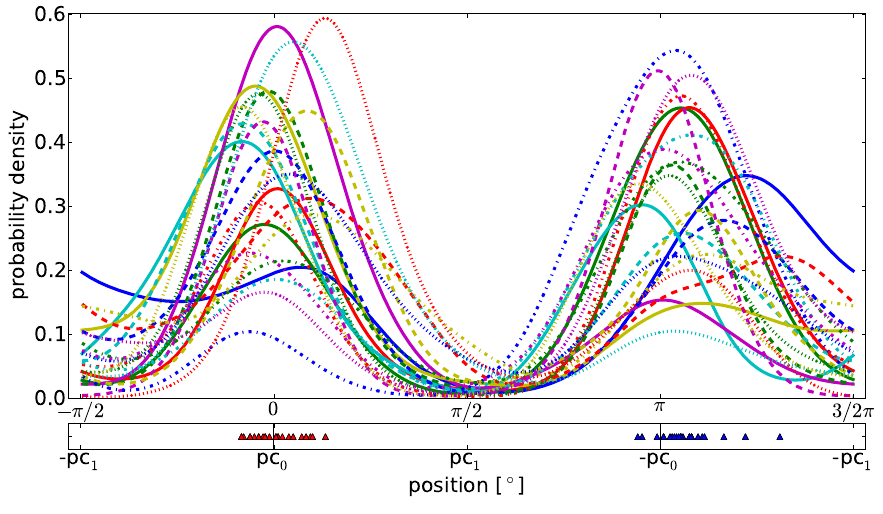
Figure 8 . ( Upper graph ) Gaussian kernel density estimation for binocular microsaccades which fit to our model and ( lower graph ) representation of the most probable shape combination of pc 0 and pc 1 for each individual participant. Each microsaccade coef- ficient pair ( c 0 , c 1 ) is transformed to the one dimensional α ( l ) with l being the index of a microsaccade. The density estimation reveals the dominance of the first principal shape pc 0 (localization around 0 and π ) above pc 1 . The lower graph shows the distribution of the most probable shapes in left and right direction and supports the former statement. This result holds for all participants. The contribution of the second component pc 1 to the microsaccade shape differs between them which we see in the different widths of the